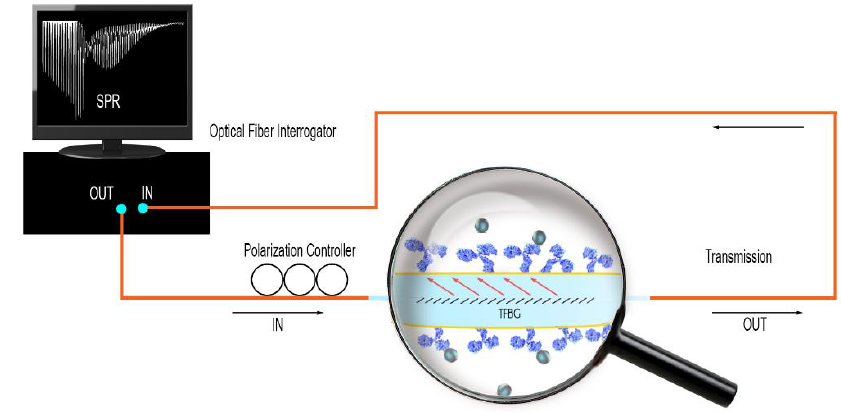
Figure 1. Scheme of the experimental setup in transmission. The gold-sputtered tilted fiber Bragg grating (TFBG) is connected using pigtails (SMF-28) to a polarization controller and an optical interrogator.